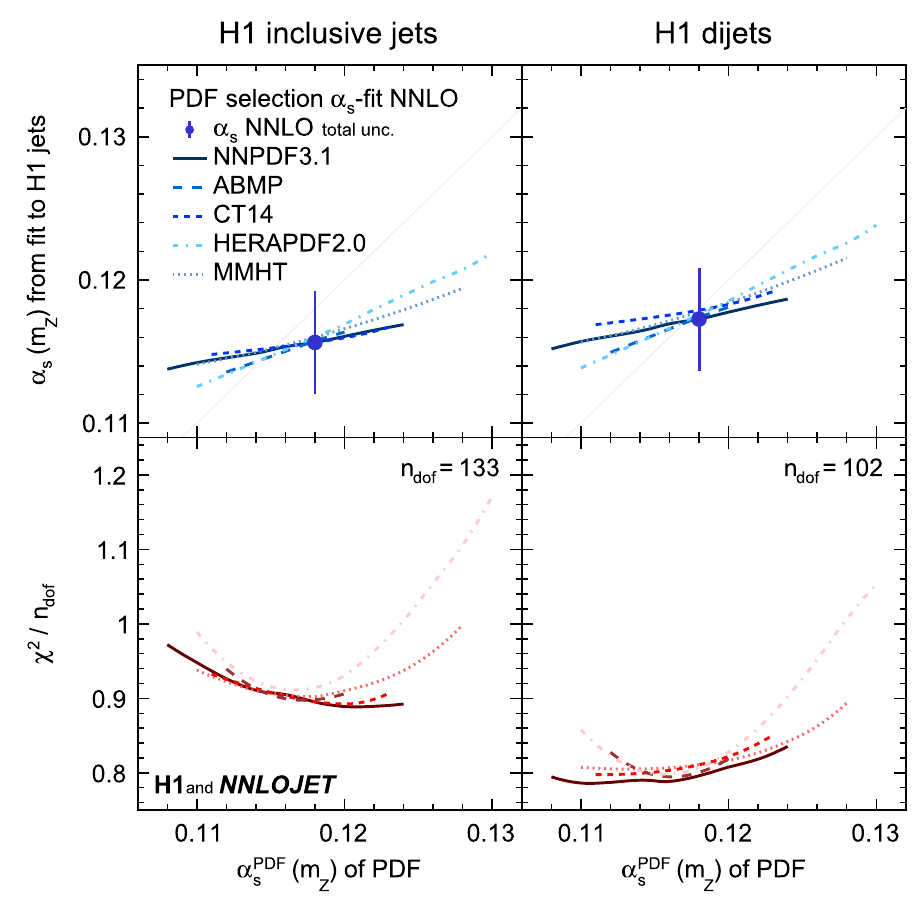
Fig. 3 Results from fits to H1 jets with two free fit parameters for α ( m ) ,wheretheappearancesof α ( m ) inthePDFevolution α (cid:4) ( m ) s Z s Z Z s and in the partonic cross sections α σ s ( m Z ) are identified separately. The ellipses display a confidence level of 68% including the experimental, hadronisation and PDF uncertainties, and thus the lines are calculated for (cid:6)χ 2 = 2 . 3. The dotted, full and dashed lines indicate the con- tour for (cid:6)χ 2 = 2 . 3 using three versions of the NNPDF3.1 set which were obtained using values for α PDF s ( m Z ) of 0.116, 0.118 and 0.120, respectively. The grey straight line corresponds to α (cid:4) s ( m Z ) = α σ s ( m Z )